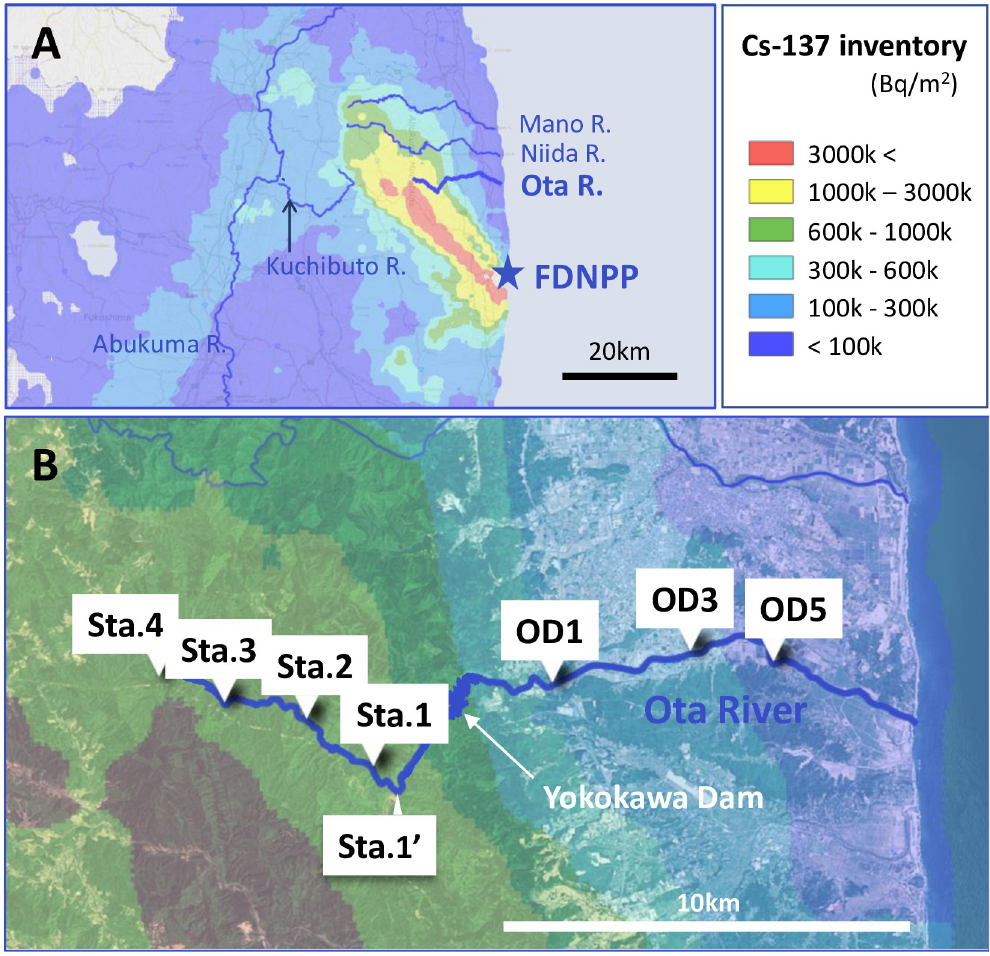
Fig 1. Map of the sampling sites at Ota River in Fukushima. The location of the Ota River and the Fukushima Daiichi Nuclear Power Plant (FDNPP) in Fukushima Prefecture (A) and a close-up of the sampling sites (B) are shown. The initial 137 Cs inventory data are derived from the study of Kato and Onda [30]. The map is based on the map obtained from Geospatial Information Authority of Japan under a CC BY